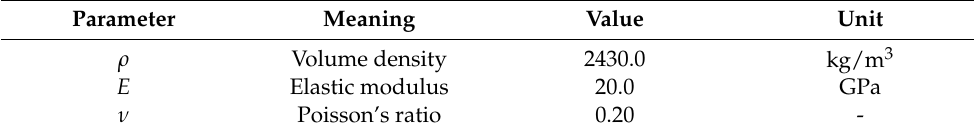
Table 8. Rock mass parameters used in SF